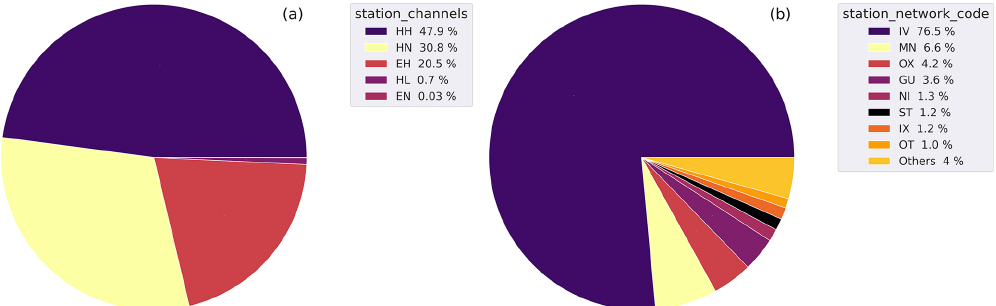
Figure 17. Pie diagrams summarizing the distribution of the channels (a) and the data contributing networks (b) of the noise dataset. The full list of station_network_code with % < 1 collected in “Others” in decreasing order is SI, YD, 3A, XO, ZM, BA, AC, HL, TV, and RF.